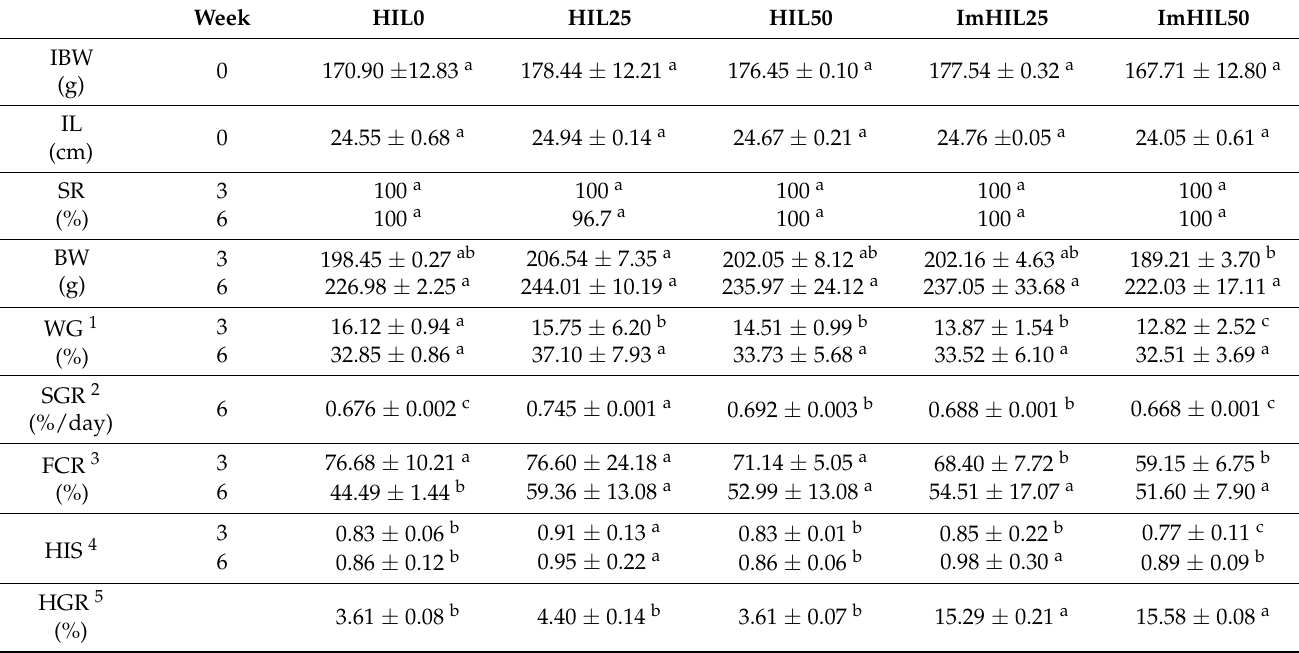
Table 3. Growth performance, survival rate, and somatic indices of rainbow trout fed with experimental diets.